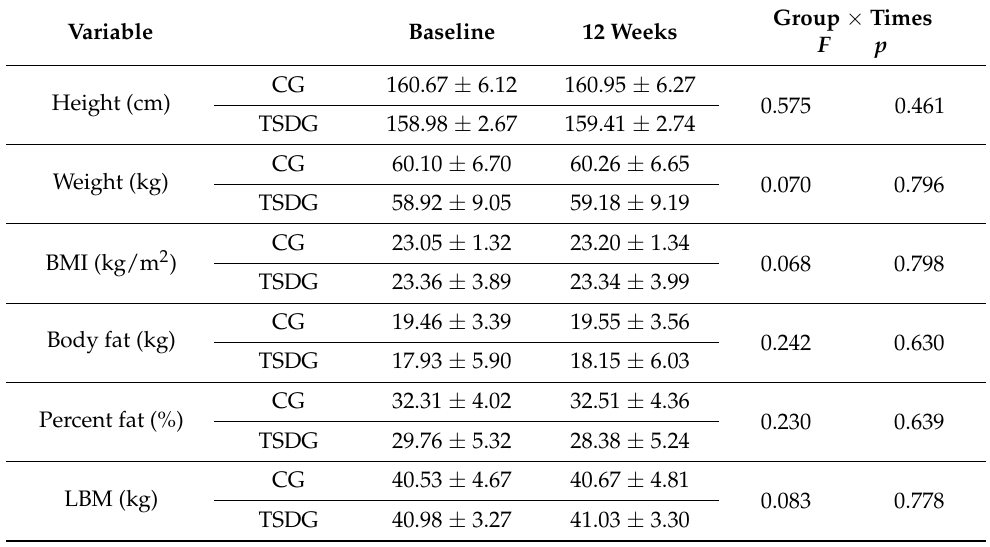
Table 4. Changes in body composition after the 12-week Taekwondo training intervention.